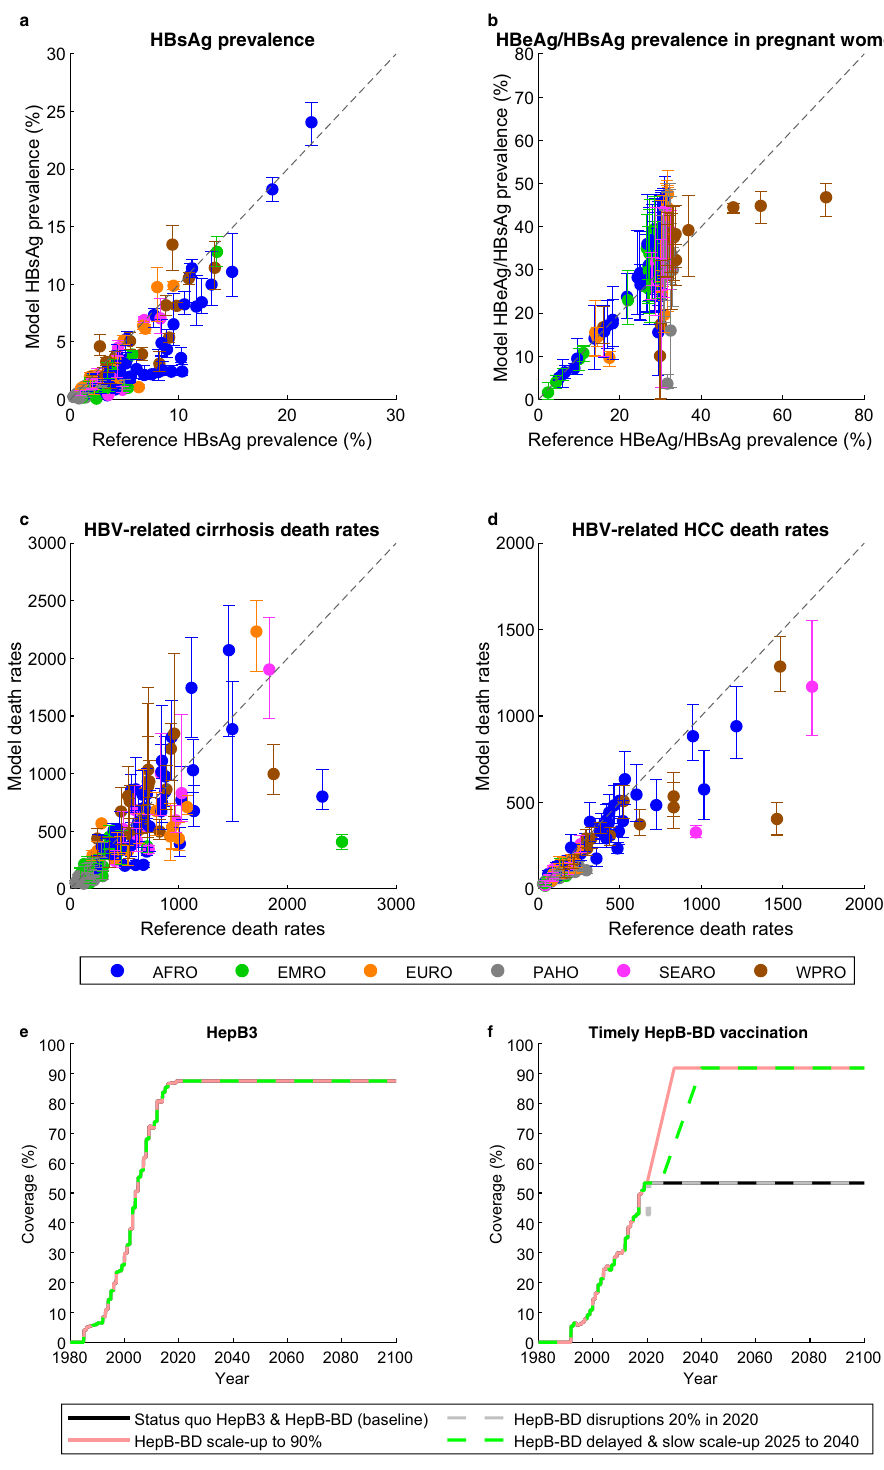
Fig. 1 The model calibrations and the scenarios used. a HBsAg prevalence in all ages, b HBeAg prevalence in HBsAg + women of childbearing age, and HBV-related death rates (deaths per 100,000) from c cirrhosis and d hepatocellular carcinoma in the 110 countries modelled compared to data from the literature in the year the data were collected. Data are presented as mean values with 95% credibility intervals of n = 200 model outcomes resulting from 200 independent draws from the posterior distribution of each country. Countries modelled in the six WHO regions AFRO, EMRO, EURO, PAHO, SEARO and WPRO are given in Supplementary Fig. 1. e HepB3 and f timely HepB-BD vaccination coverage globally in selected scenarios (see Table 1). Note that all four lines co-incide in Fig. 1e. In Fig. 1f, the Status quo HepB3 & HepB-BD (baseline) line appears dashed where it co-incides with the HepB-BD disruptions 20% in 2020 line and the HepB-BD scale-up to 90% line appears dashed where it co-incides with the HepB-BD delayed & slow scale-up 2025 to 2040 line. HBeAg: hepatitis B e antigen; HBsAg: hepatitis B surface antigen; HBV: hepatitis B virus; HCC: hepatocellular carcinoma; HepB3: infant HBV vaccine series; timely HepB-BD: timely birth dose; WHO: World Health